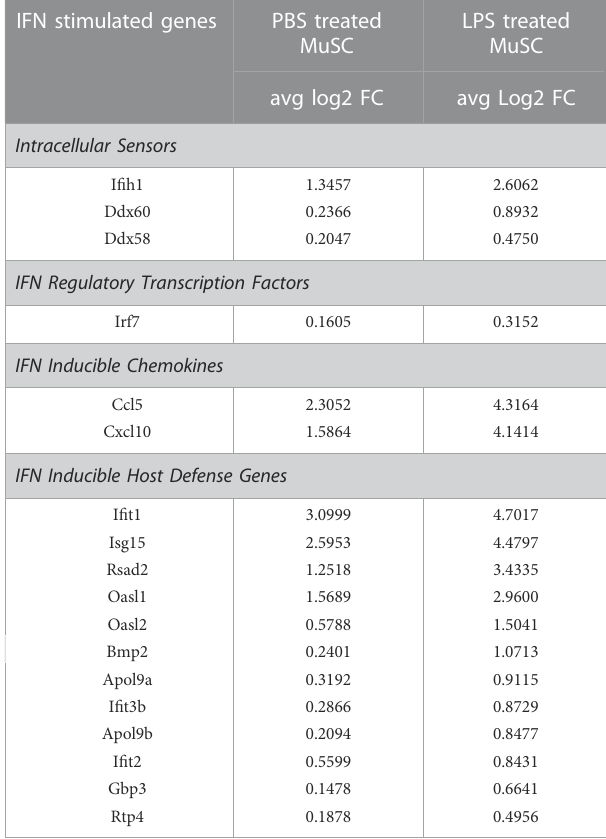
TABLE 1 Induction of genes in the antiviral IFN pathway in the ISC cluster of PBS and LPS treated MuSCs. Transcription of genes reported to participate in theantiviralIFNpathwayorbedownstreaminducedgeneswerequanti fi edby scRNA-Seq and expressed as Log2 fold change above average expression across all cells in the PBS- or LPS-treated MuSC library.